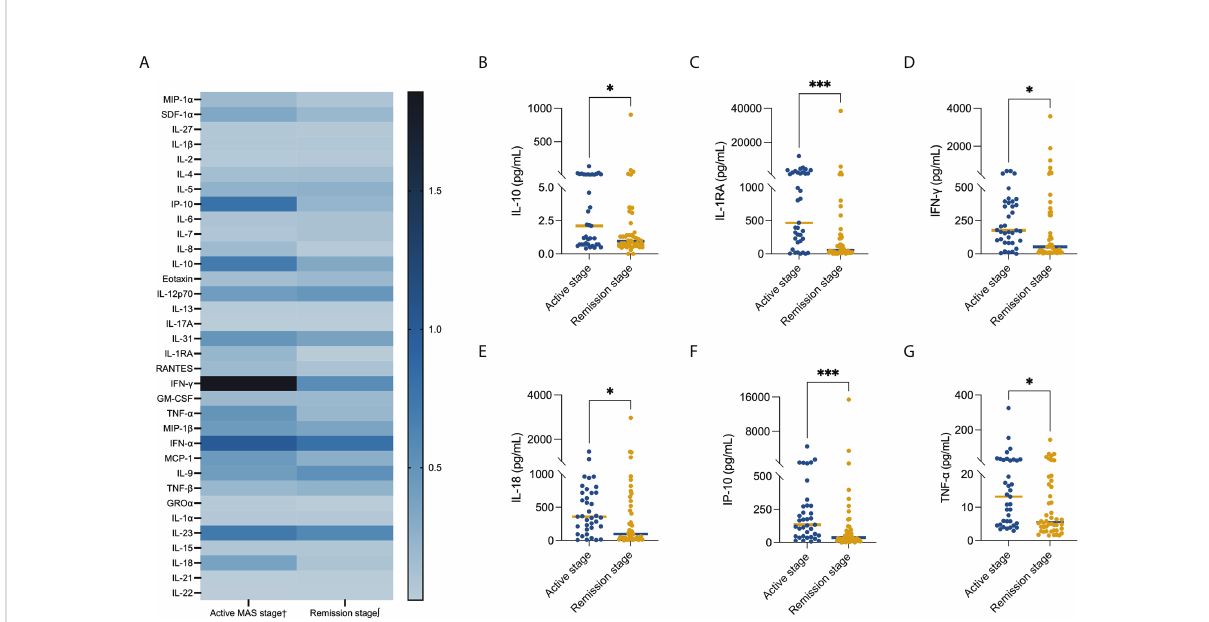
FIGURE 2 Comparison of the serum cytokine level in different MAS stages. Serum levels of (A) all evaluated cytokines, (B) IL-1 (P = 0.041), (C) IL-1RA (P < 0.001), (D) IFN- g (P = 0.013), (E) IL-18 (P = 0.021), (F) IP-10 (P = 0.001), and (G) TNF- a (P = 0.020). The bars represent median values. Statistically signi fi cant differences between each patient group are shown as *P < 0.05, ***P < 0.001. † Data available in 37cases. ∫ Data available in 46 cases.